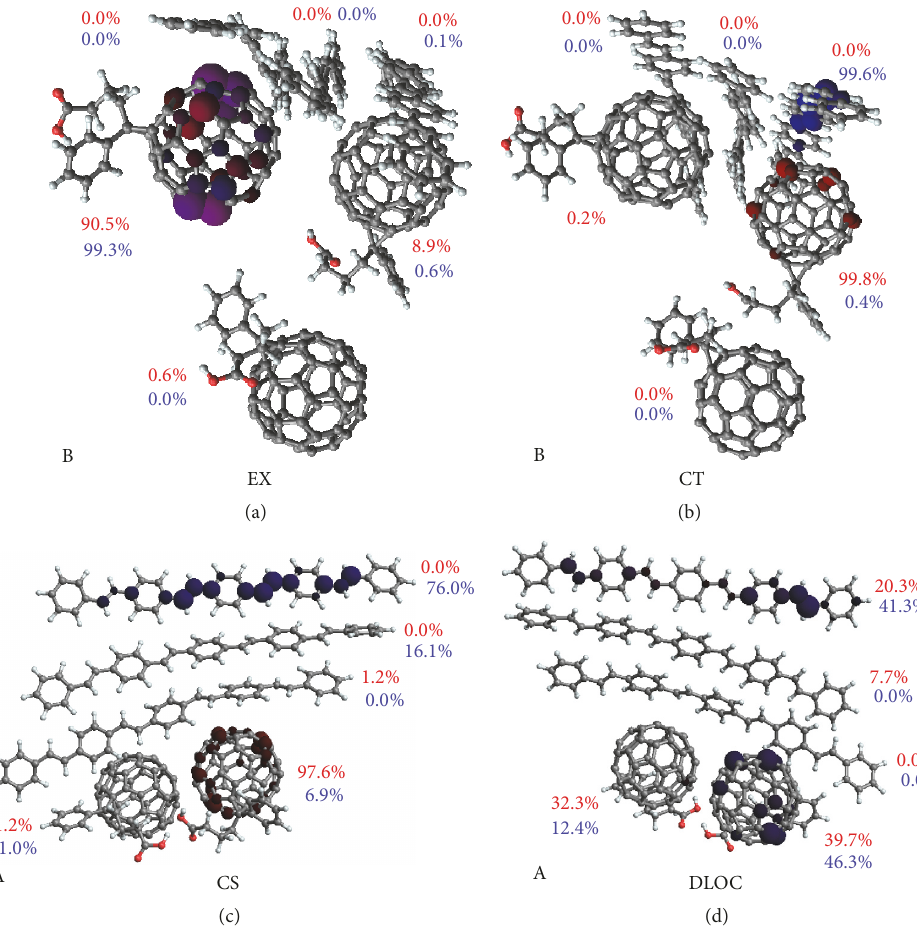
Figure 2: The dominant adiabatic states from simulations A (c, d) and B (a, b) as shown in Figure 1 The red and blue numbers denote the electron/hole density as a percent on the indicated molecule. The states correspond to the 𝑥 -axis in Figure 3. The four snapshots shown represent typical states for our systems. (a, b) from left to right present an exciton located on the PCBM molecule and a charge-transfer state. (c, d) from left to right show a charge-separated state and a partly delocalized state.